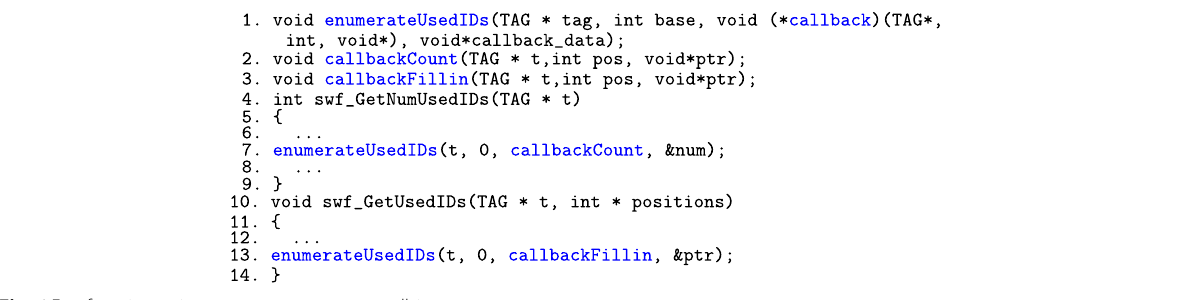
Fig. 6 E.g., function pointer as an argument at a